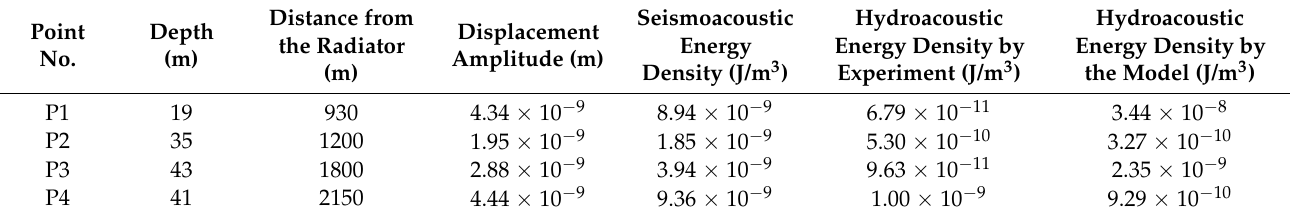
Table 2. Seismoacoustic and hydroacoustic energy